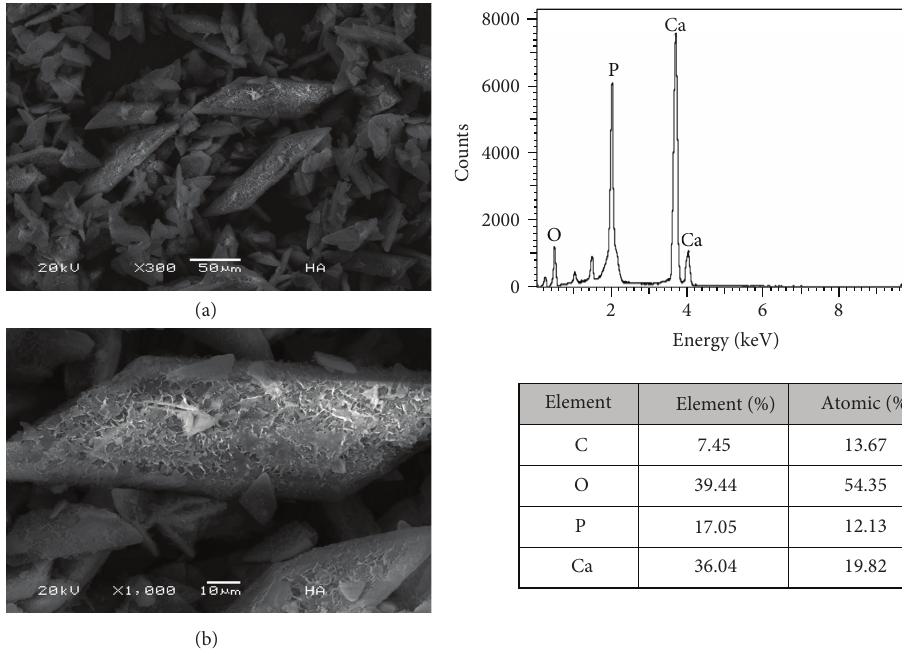
as minimal for minute. e second portion describes the micropore diffusion before equilibrium is attained. Both macropore and diffusions are faster for Eu(III) than for 𝑡𝑡 𝑡 1 La(III). Finally, the third horizontal line describes the equi- librium condition, where A comparison of the values obtained for the La(III) and Eu(III) adsorption on hydroxyapatite with those data collected in literature about the adsorption of these REE on 𝑞𝑞 max different inorganic materials is shown in Table 2. ese data show that synthetic hydroxyapatite exhibits an adsorption capacity toward La(III) and Eu(III); moreover, this material can be useful for removing REE from aqueous solutions. 3.3. Adsorption Isotherms. An adsorption isotherm is char- acterized by certain constants whose values express the surface properties and affinity of the adsorbent that can also be used to �nd the adsorptive capacity of adsorbent at equilibrium. us, the equilibrium distributions of La(III) and Eu(III) ions between the liquid phase and the solid adsorbent phase (hydroxyapatite) were studied as a function of ion initial concentrations. e initial concentration ranges were 3.3 europium. No one of these isotherms ( ) attained a plateau. erefore, they were surveyed by means of the adsorption isotherm model of Freundlich, using both linear and nonlinear equations, whose results were identical. e values of were higher than 1 in all cases. e obtained straight lines are shown in Figure 5. When Langmuir and Langmuir-Freundlich models were applied the slopes of the 1𝑡𝑛𝑛 lines were negative; therefore, data were not well �tted to these